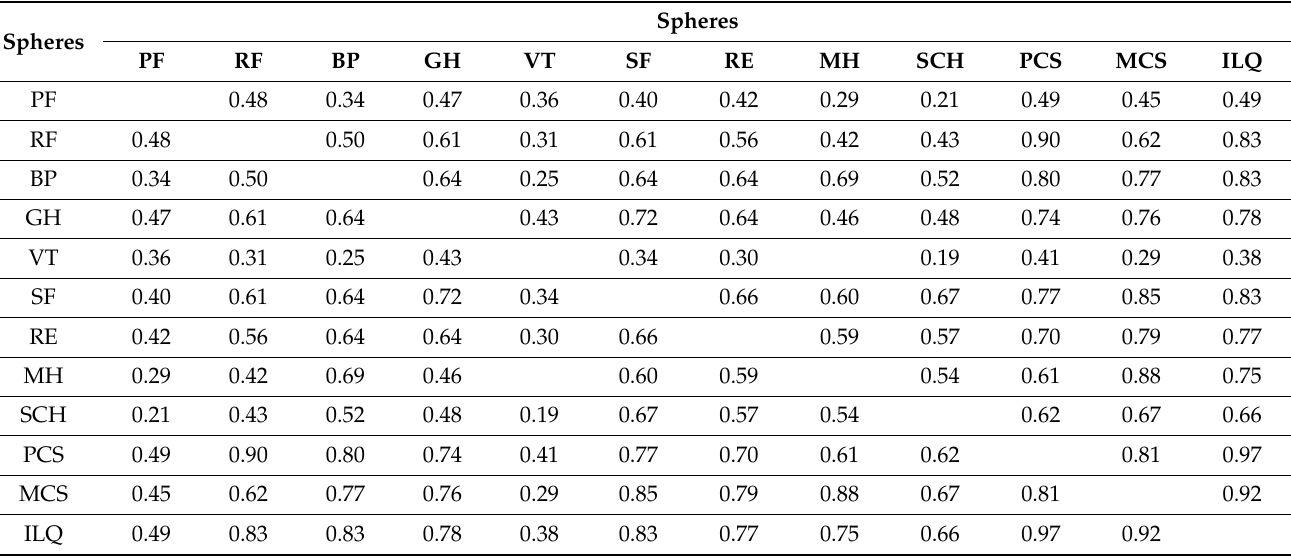
Table A3. Correlations of SF-36 spheres for the age group of 71–75 years (Spearman’s r coefficient).